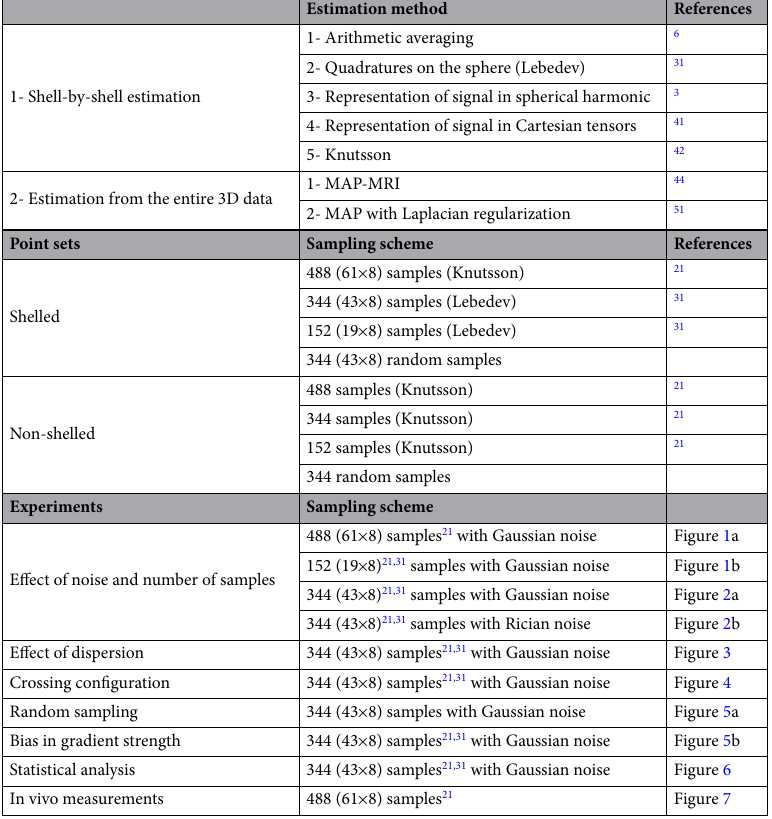
Representation of the single-shell signal in a series of spherical harmonics: Any square-integrable func- x ) , defined over the unit sphere, can be represented in a spherical harmonic basis through the expansion tion, F ( ˆ